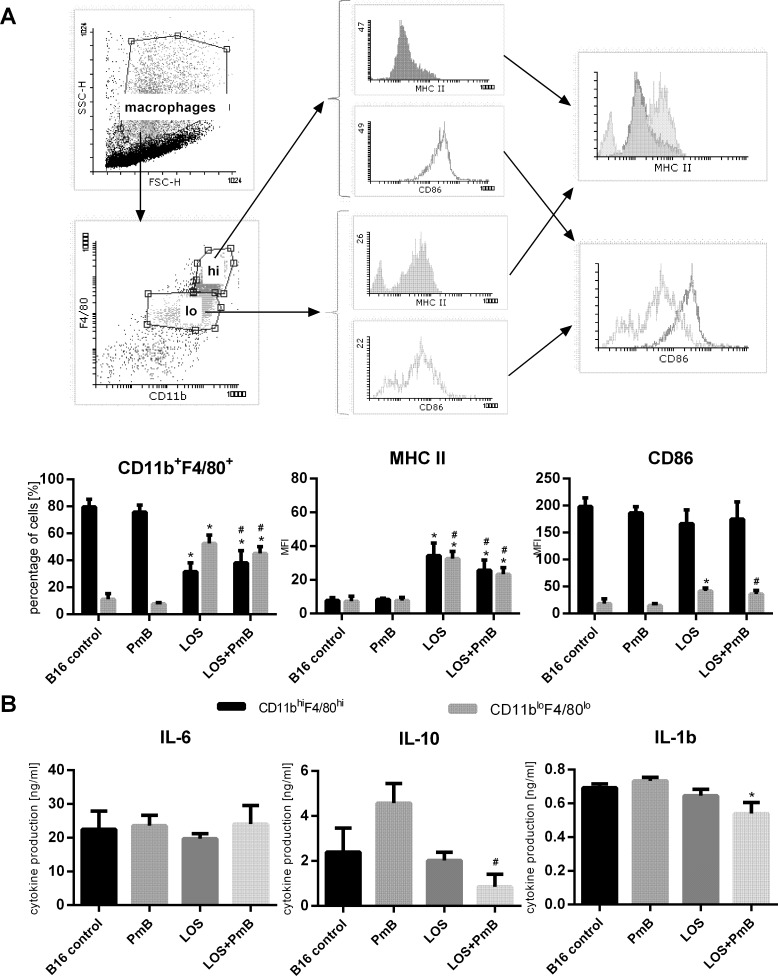
A. Phenotypic characteristics of peritoneal macrophages. Peritoneal macrophages obtained from control or treated tumor bearing mice on 7th, 14th and 21st day of experiment were stained in one-step test with following fluorophore-labeled monoclonal anti-mouse antibodies (mAbs): anti-F4/80-APC, anti-CD11b-PerCP-Cy5.5, anti-MHCII-FITC or anti-CD86-PE. Phenotypic characteristics of peritoneal macrophages obtained from healthy mice: CD11bhiF4/80hi – 67.23% (CD86 MFI—224, MHC II MFI—9), CD11bloF4/80lo – 11.22% (CD86 MFI—20, MHC II MFI 8) B. Cytokine production by peritoneal macrophages obtained from mice on 7 th day after in vitro LOS stimulation. The production of IL-6, IL-10 and TNF-α by stimulated (LOS 1μg/ml, 24h) peritoneal macrophages (1x106 cells/ml) was evaluated by ELISA kits (BD Bioscience). In this supernatants, production of IL-4 was not observed. To calculate the mean four mice of each presented group were tested. Cytokine production by peritoneal macrophages obtained from healthy mice: IL-6–14.45±3.76 ng/ml, IL-10–3.58±1.13 ng/ml, IL-1β – 0.25±0.12 ng/ml. The relationship between groups was calculated for n>13 using Mann-Whitney U test. differences with a p<0.05 were regarded as significant (*p<0.05- calculated vs untreated mice, #p<0.05—calculated vs mice treated with PmB).